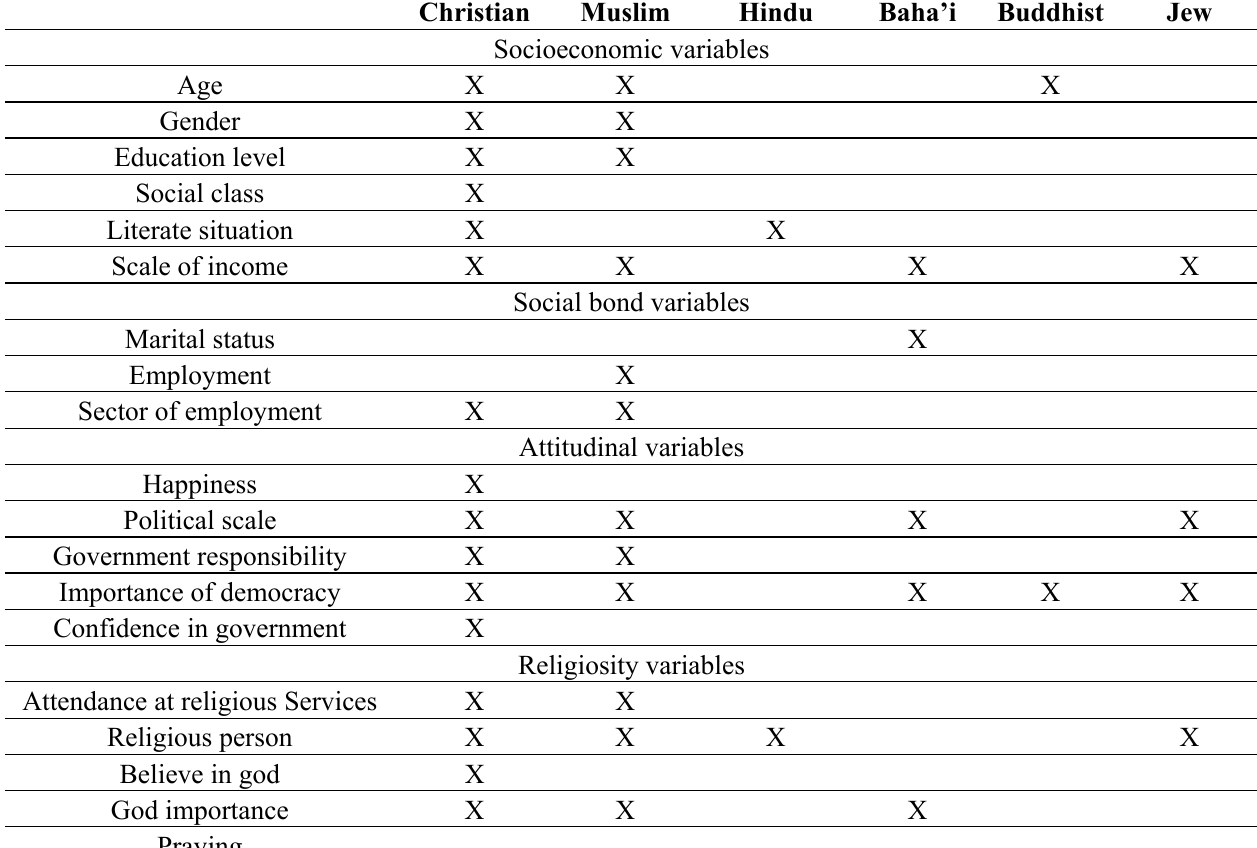
Table 4. Summary of significant